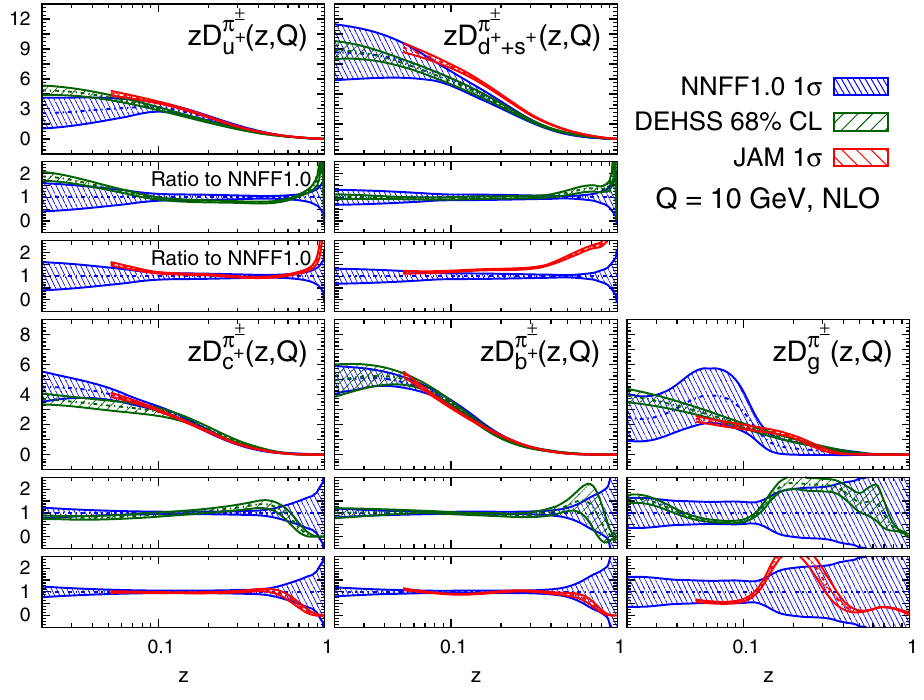
Fig. 12 Comparison among the NLO NNFF1.0, DEHSS and JAM FF sets for the sum of charged pions, π ± . The FFs in the parametrisation basis, Eq. (4.1), are shown at Q = 10 GeV as a function of z , together